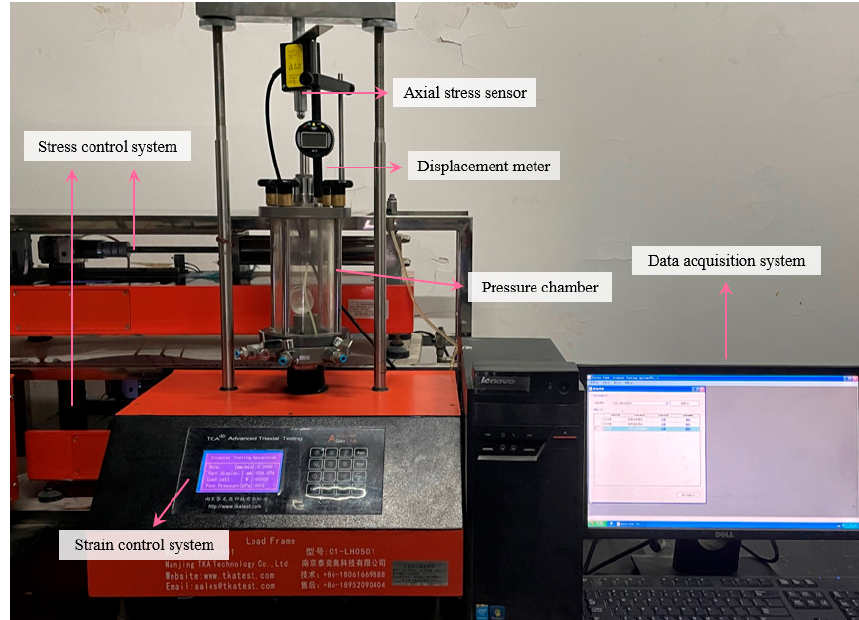
Figure 2. Full-automatic stress path triaxial apparatus.